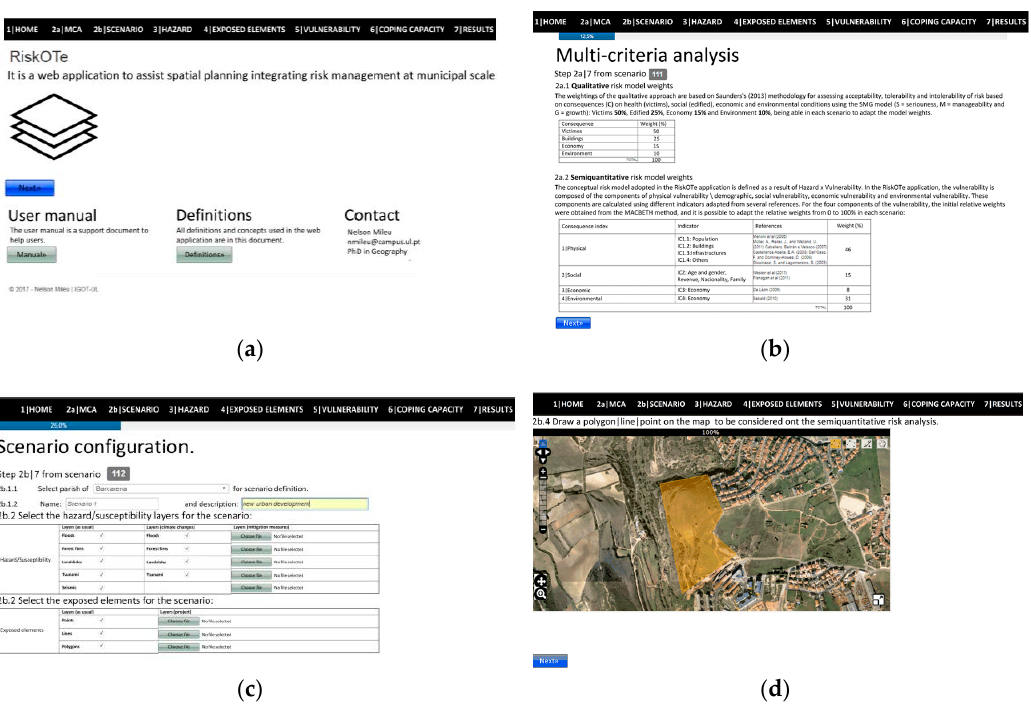
Figure 5. RiskOTe SDSS first steps: ( a ) Home page; ( b ) Multicriteria weighting; ( c ) Scenario definitions; ( d ) Location drawing.